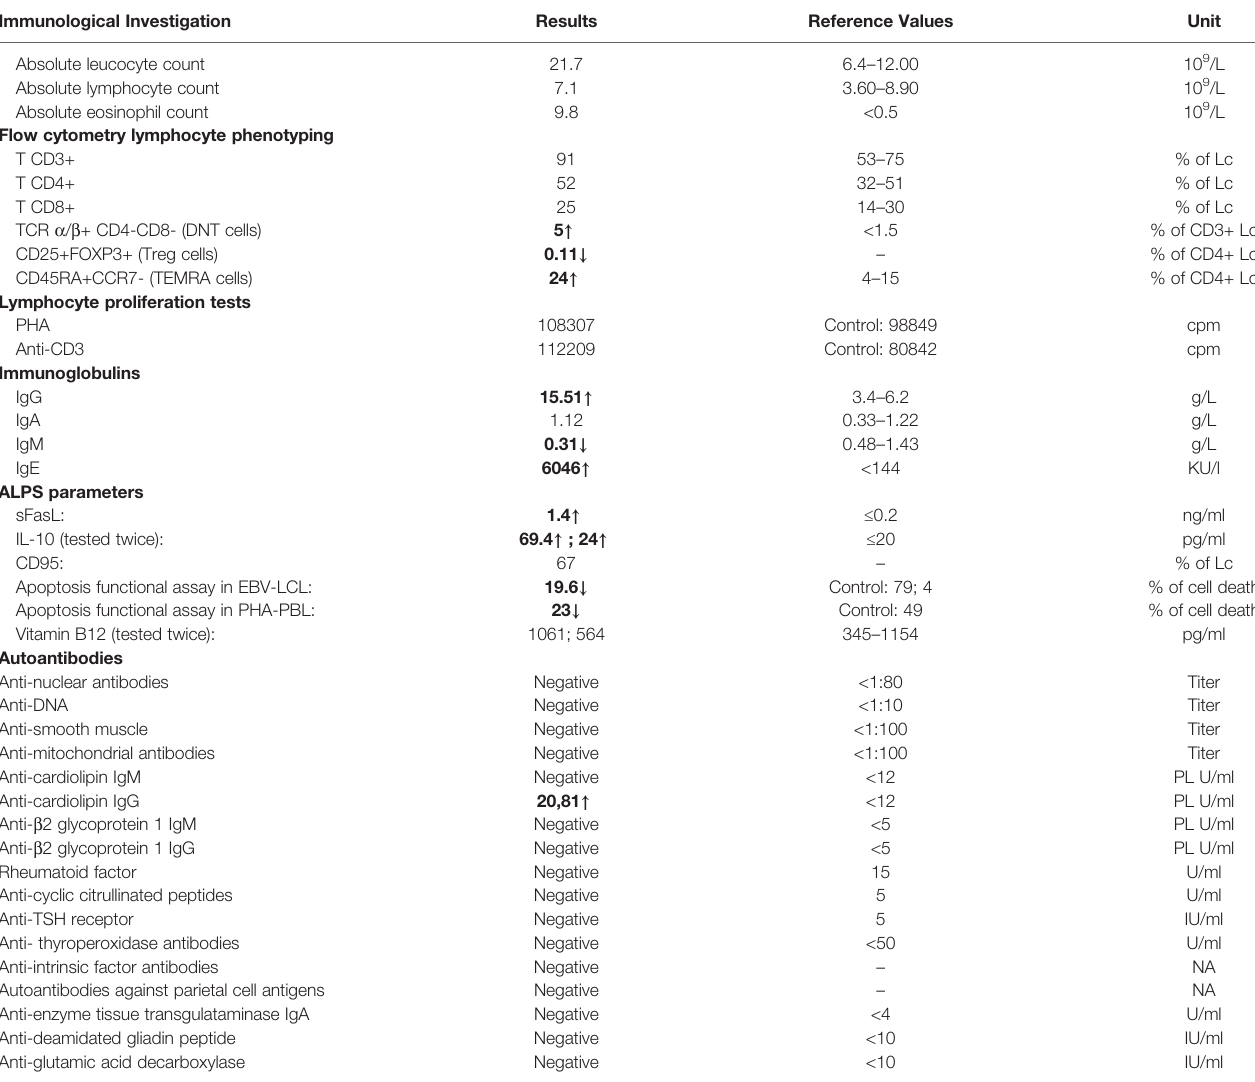
TABLE 1 | Results of the immunological